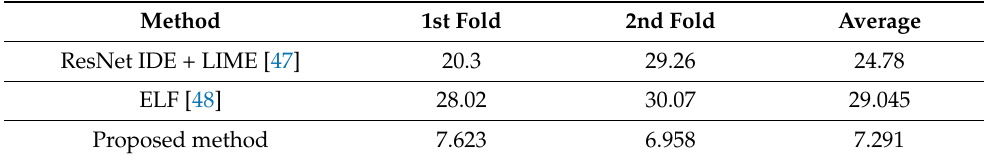
Table 12. Comparison of EERs using the proposed method and the previous body and face recogni- tion techniques (unit: